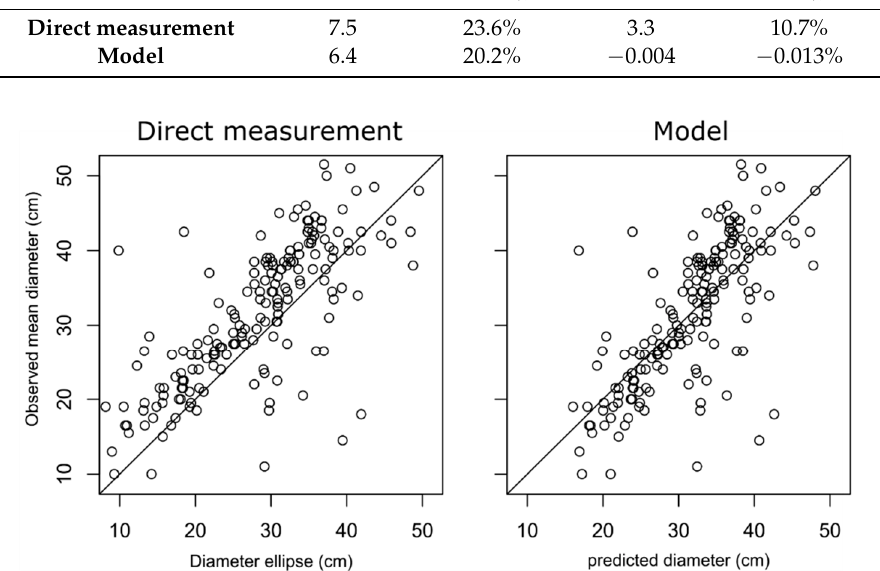
Figure 8. Scatterplots of the mean between two field measured cross-sectional diameters ( D ) against the diameters obtained either through direct measurement (left panel) or through a diameter model (right panel). For the direct measurement method, the x -axis represented the diameter of the circumference with area equal to an ellipse fitted to the vertices of the segmented polygons (Diameter ellipse). For the modelling method, the x -axis represented the loocv predicted diameter.